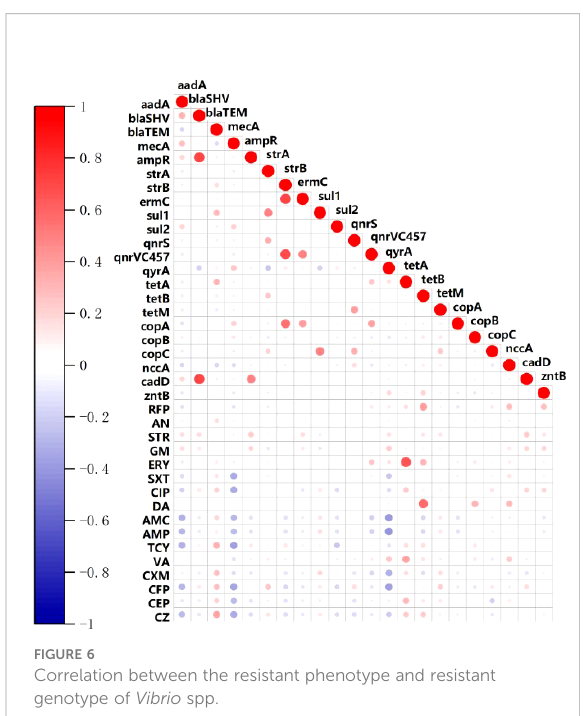
FIGURE 6 Correlation between the resistant phenotype and resistant genotype of Vibrio